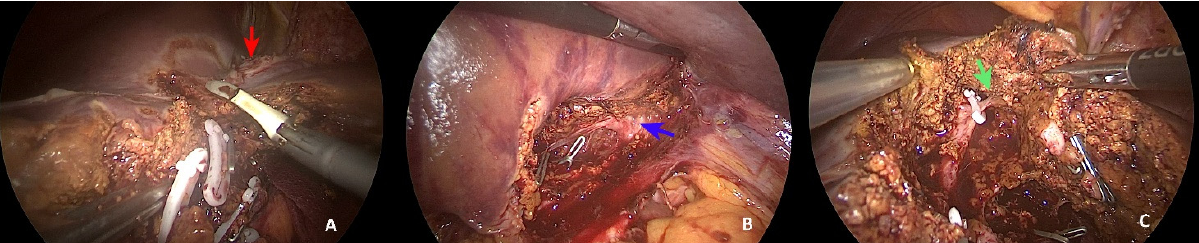
Figure 2. Parenchymal dissection . ( A ) Dissection between segments 4a and 4b (red arrow: liver metastasis); ( B ) exposure of inferior part of common trunk (blue arrow) using the Arantius approach; ( C ) cone unit of segment 4a (green arrow).